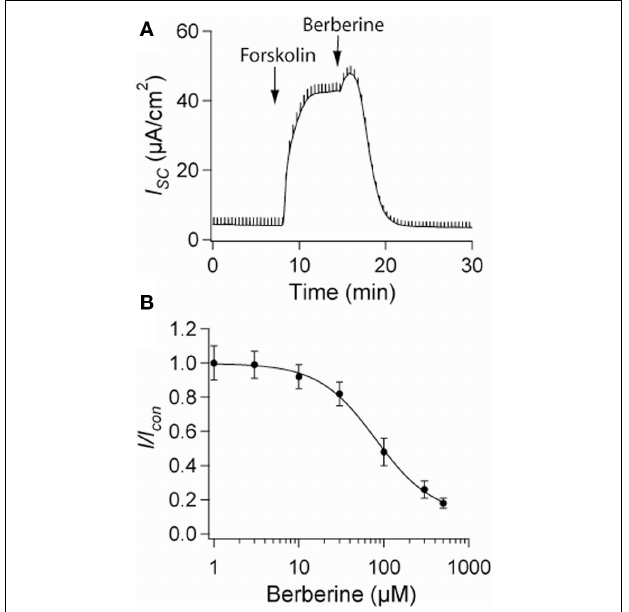
FIGURE 1 | Effect ofberberine on forskolin-induced Cl − secretion. (A) Representative short-circuit current recording of the effect of berberine (300 μ M) on forskolin-stimulated I SC inT84 cell monolayers. Drugs were added at arrow and remained in the bathing solutions throughout the experiment (B) Concentration-response curve for the antisecretory effect of berberine on forskolin-stimulated I SC inT84 cell monolayers. Change in I SC measured 15min post berberine application at different concentrations. Values are mean ± SEM n = 8 for each